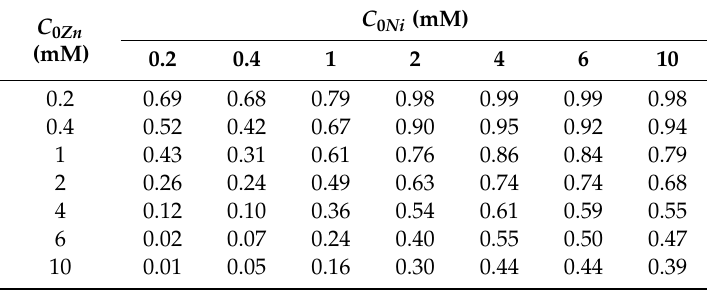
Table 2. The ratio of Ni 2 + biosorption capacity ( R qNi ) at di ff erent initial Zn 2 + concentrations.